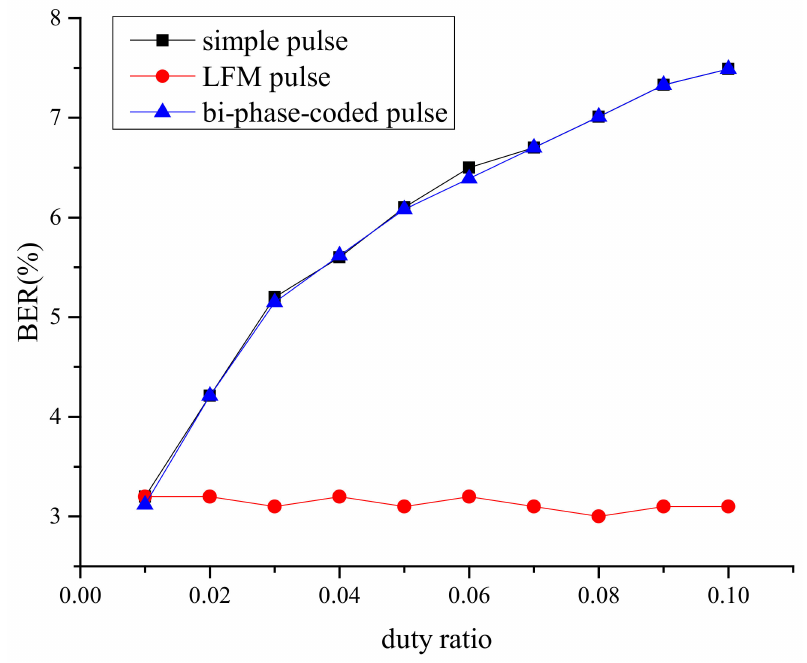
Figure 12. The curve of BER with pulse duty